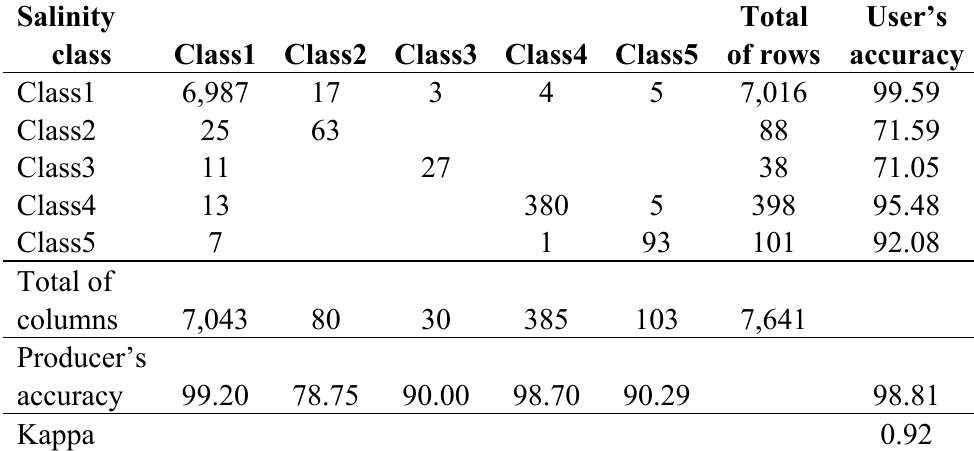
Table 6. Producer’s, user’s, overall accuracy and Kappa coefficient for predicted soil salinity classes developed with 10 trials of